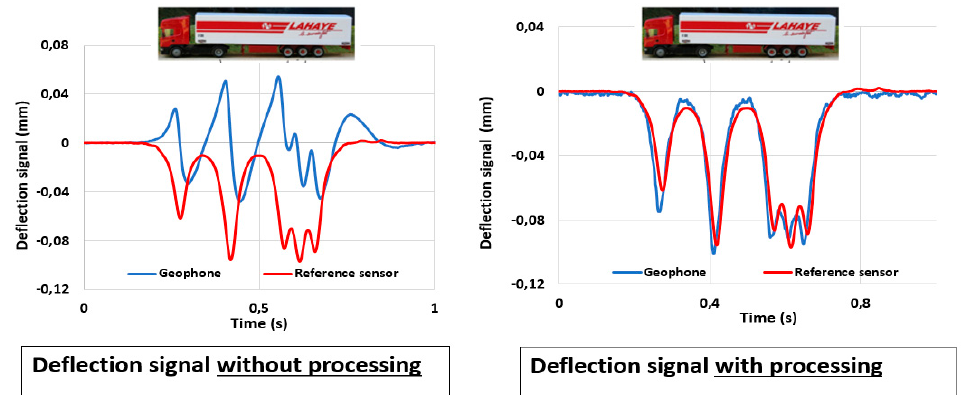
Figure 9. Example of comparison between the geophone signal obtained with and without the improved processing method.